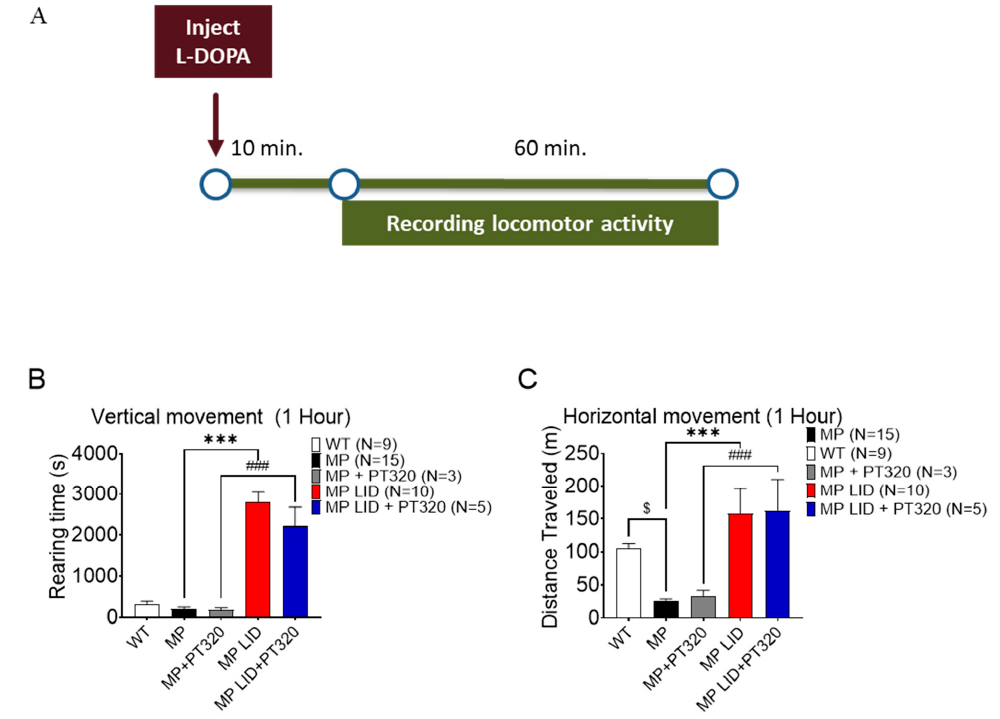
Figure 4. Effect of PT320 combined with L-DOPA on MP locomotion. Locomotor assessments showed no significant differences between groups. ( A ) Experimental protocol for locomotor assessment: one